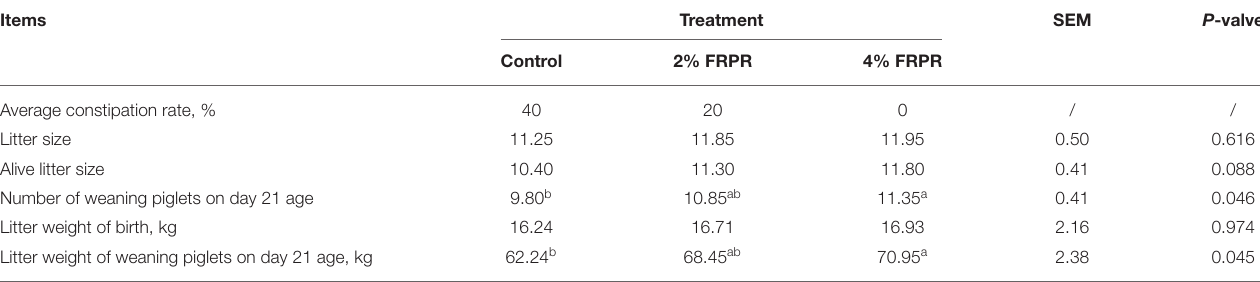
TABLE 2 | Effect of dietary supplementation with fermented Radix puerariae residue (FRPR) on reproductive performance of the sows 1